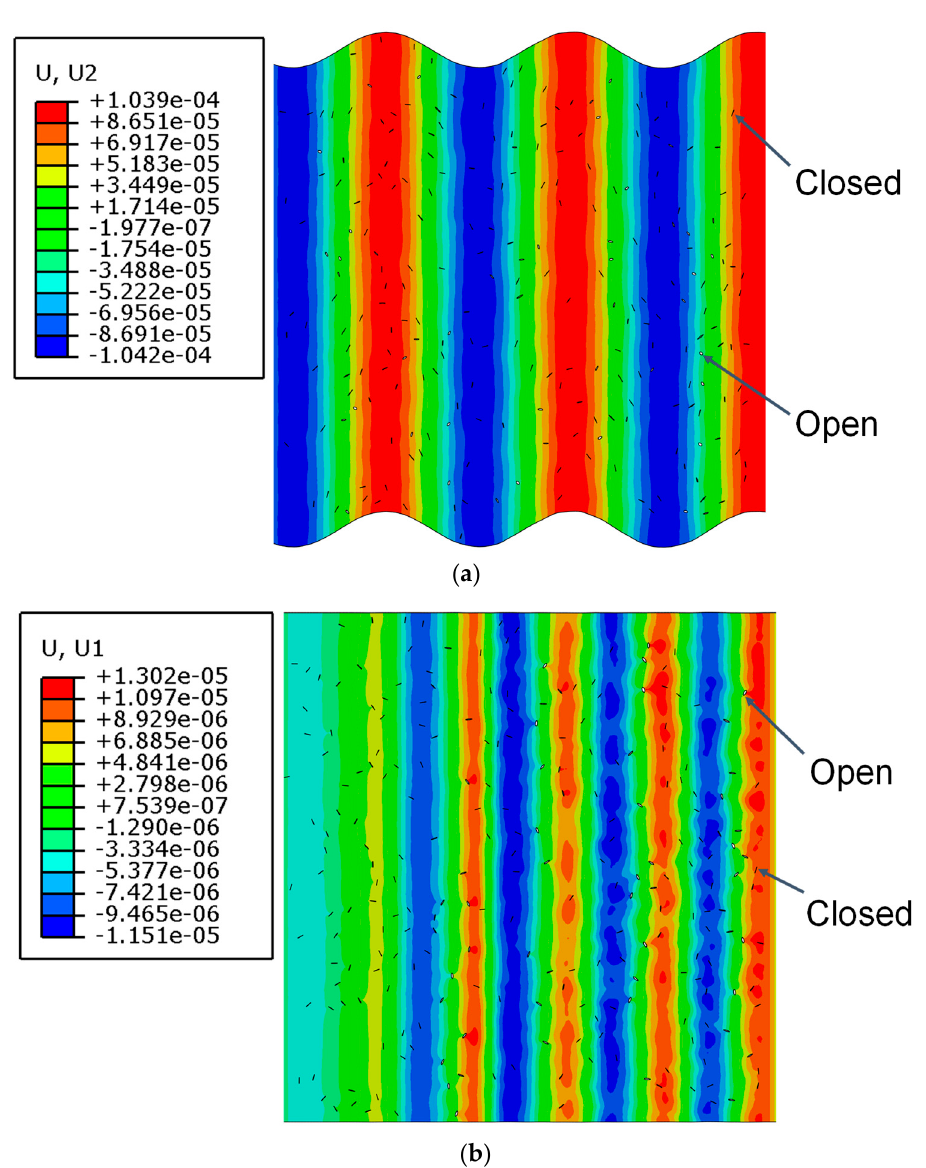
Figure 4. Propagation of transverse and longitudinal wave pulses in the micro-crack region ( c = 0.009375, f R = 6 MHz, μ = 0, L 1 = 40 mm, L 2 = 4 mm, L 3 = 36 mm). ( a ) Displacement contour in the x direction. ( b ) Displacement contour in the y direction.